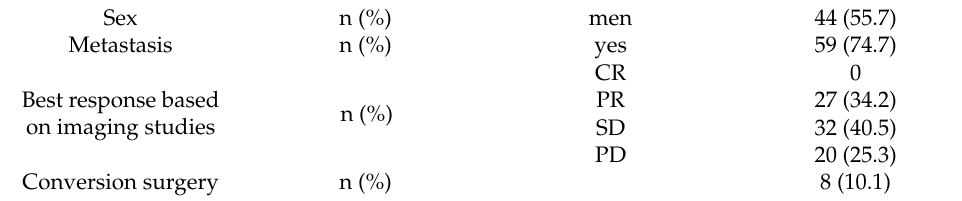
Table 1. Basic characteristic of all 79 patients.